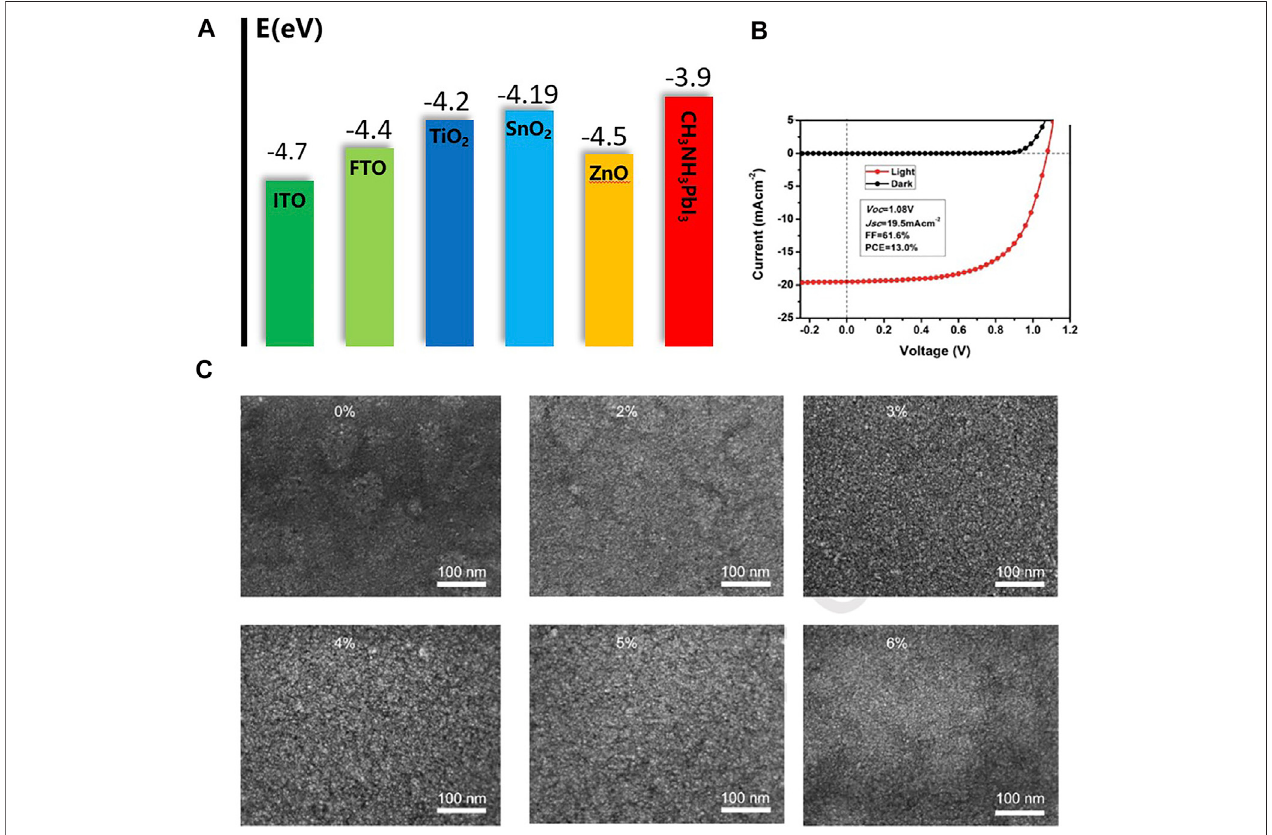
FIGURE 6 | (A) Energy level diagram of common ETL materials and other functional layers. (B) J-V curves of the highest performing PSCs devices measured in 100 mW cm − 2 AM1.5 Gilluminationanddarkness. (C) TheSEMimages ofSnO 2 fi lms(pristine SnO 2 ,2%Li:SnO 2 ,3%Li:SnO 2 ,4%Li:SnO 2 ,5%Li:SnO 2 ,6%Li:SnO 2